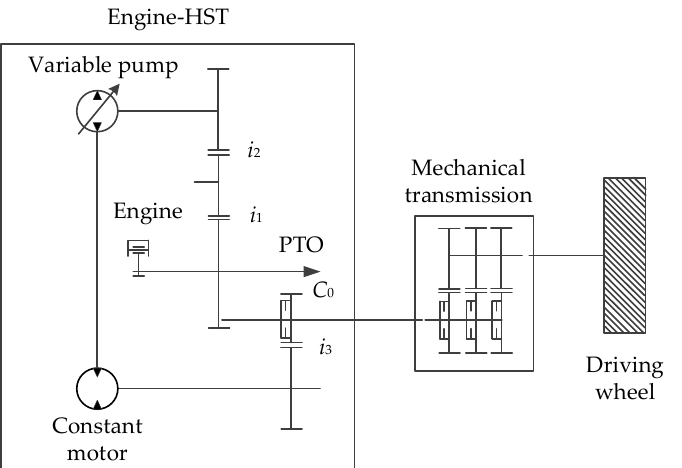
Figure 1. The schematic diagram of the continuously variable transmission system of the tractor with the HST.